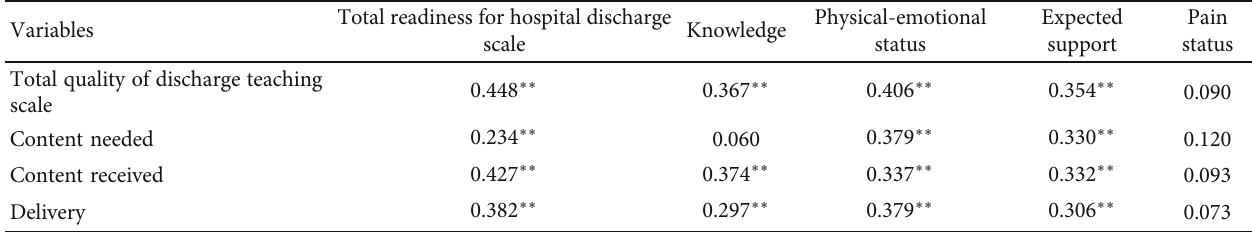
Table 4: Coe ffi cient for the correlation between the discharge instructions quality and readiness for discharge from the hospital among premature infants ’ parents ( N = 208